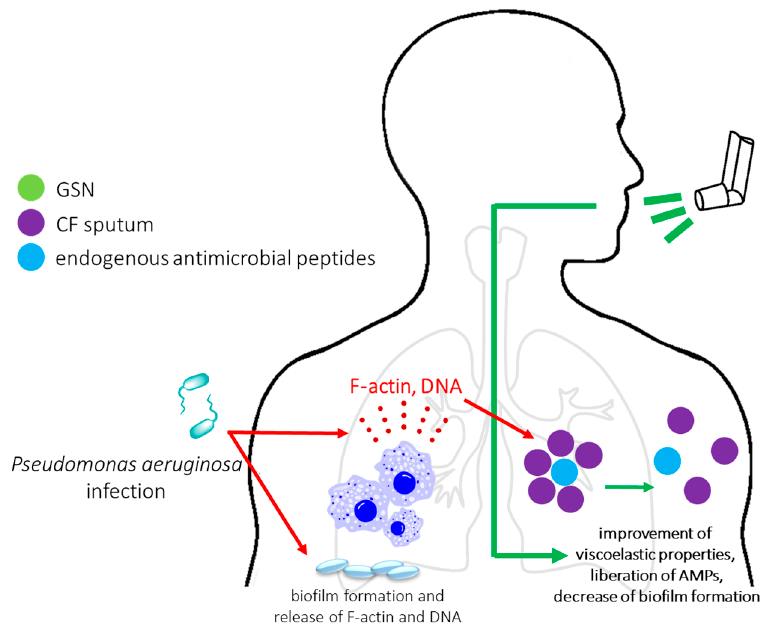
Figure 4. The mechanisms of therapeutic action of extracellular gelsolin administrated in the form of aerosol in cystic fibrosis patients infected with Pseudomonas aeruginosa .